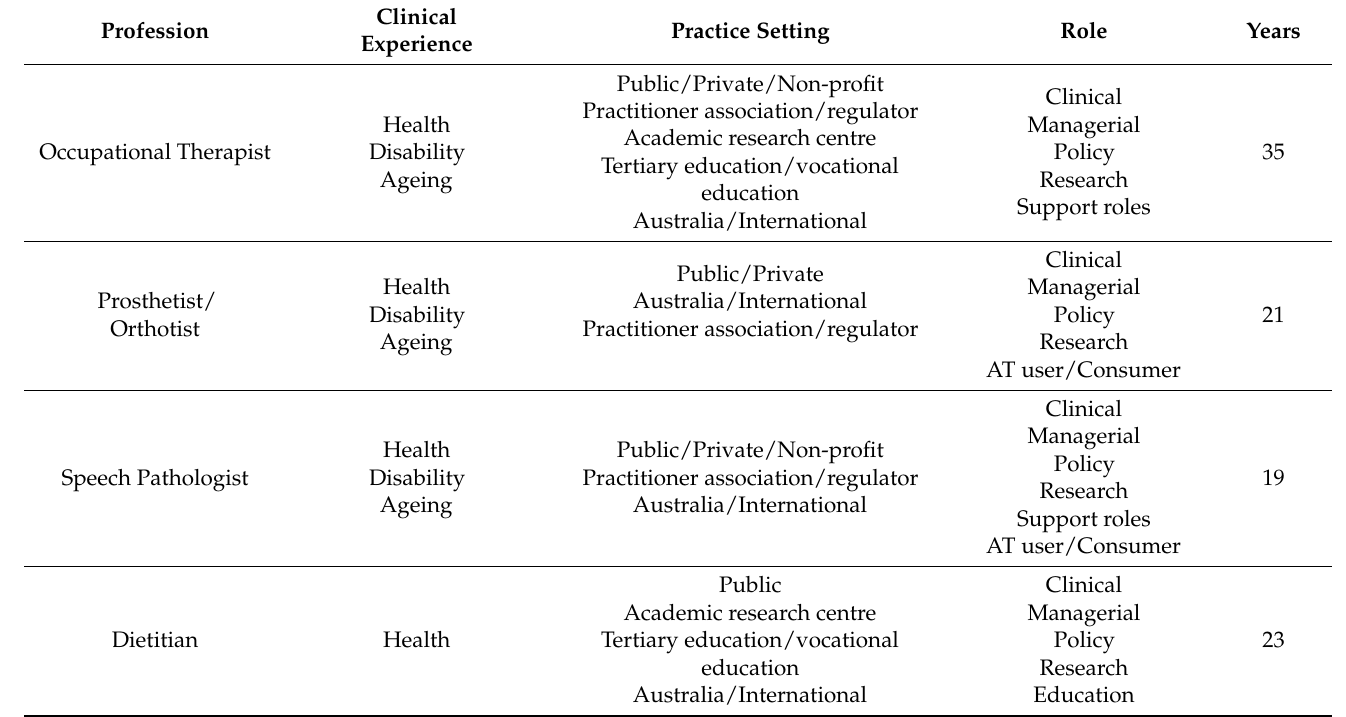
Table 1. Participant